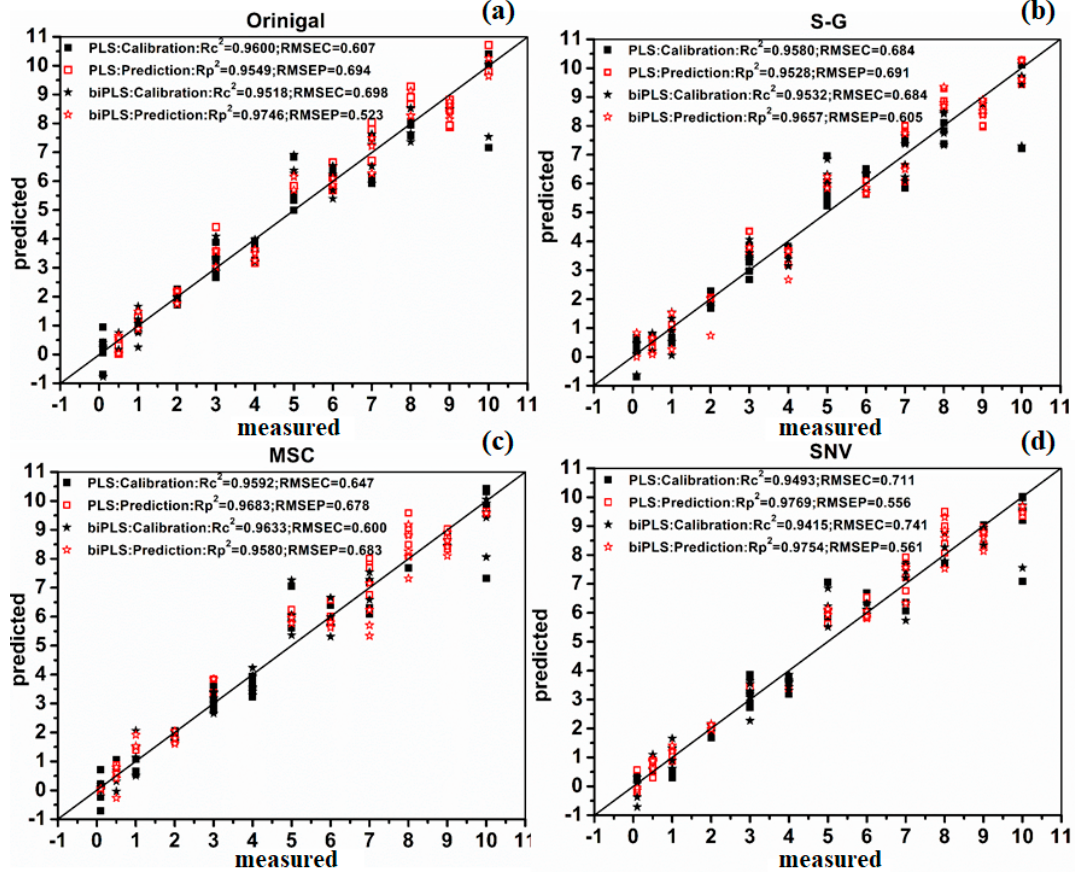
Figure 7. Scatter diagram of calibration set and prediction set by PLS and biPLS using different preprocessing methods: ( a ) original plot; ( b ) S-G; ( c ) MSC; ( d ) SNV.